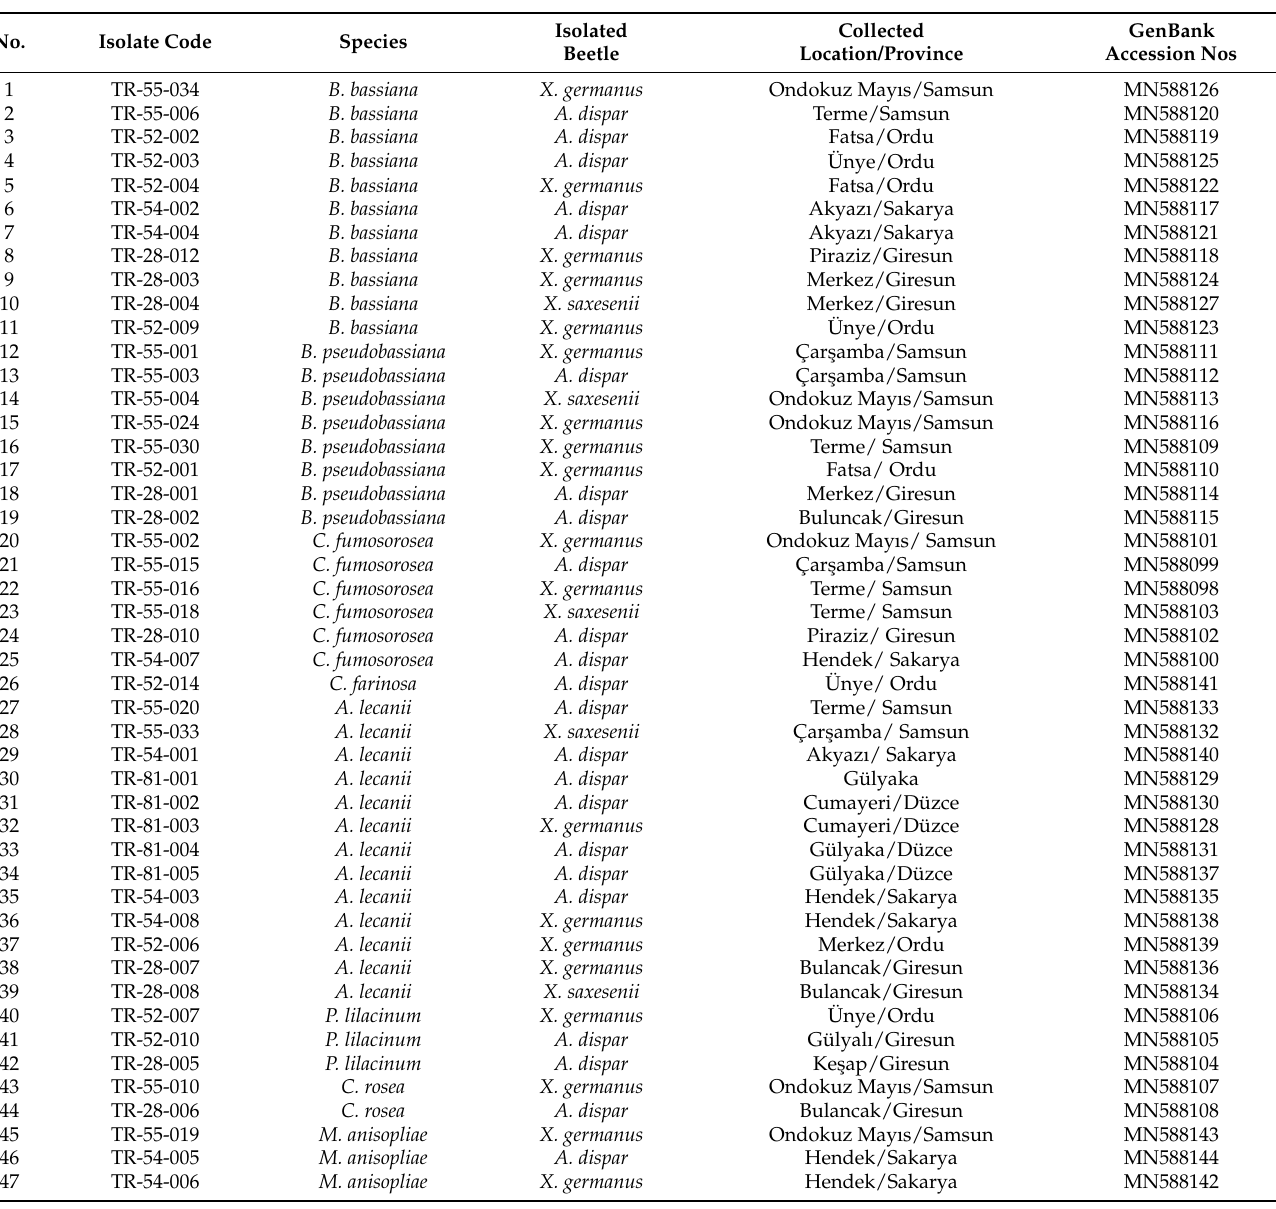
Table 1. Information about isolated entomopathogenic